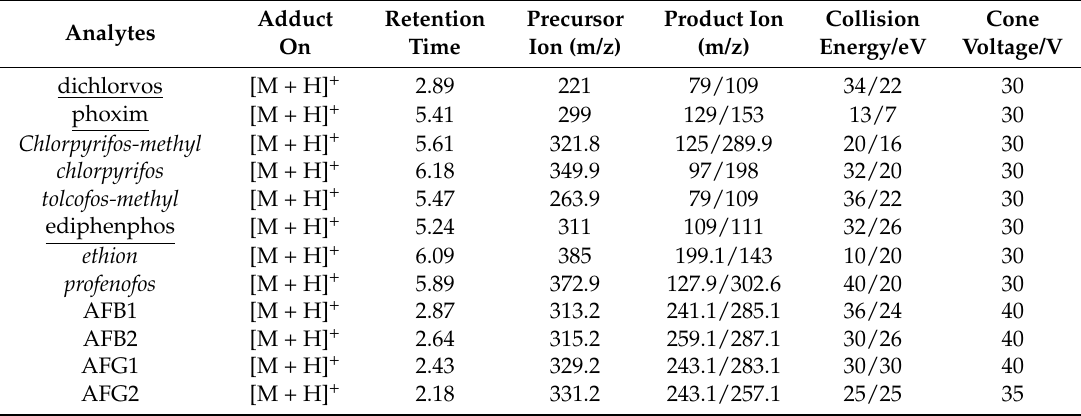
Table 1. The MS/MS parameters of the aimed pesticides and